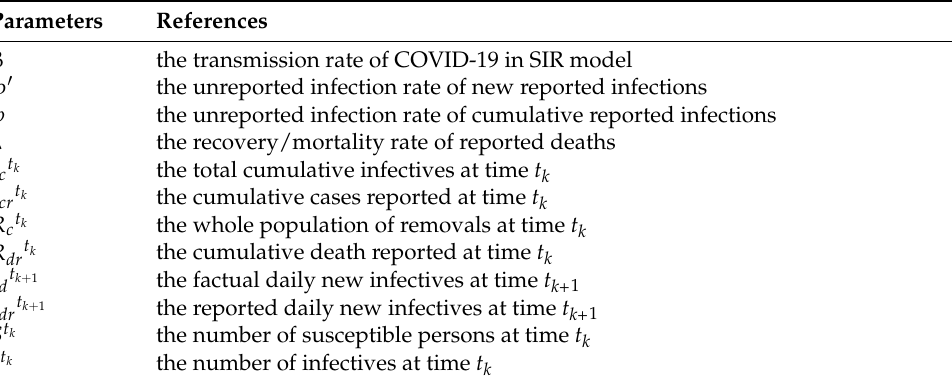
Table A3. Parameters Table List.